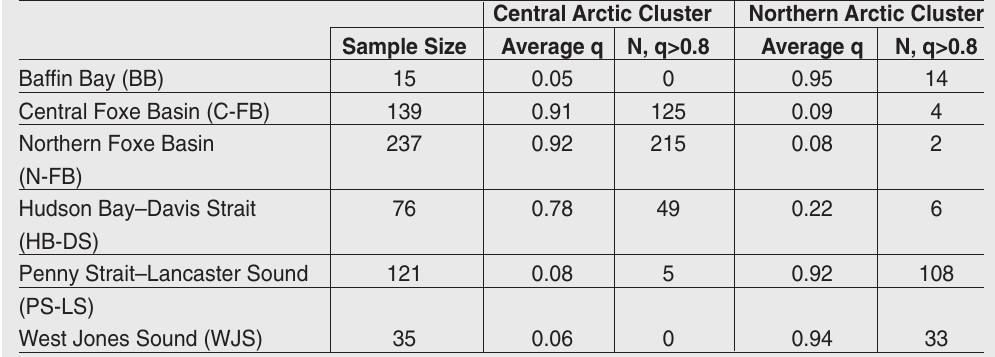
Table 5 . Genetic assignment matrix. Average assignment and number of individuals strongly assigned (q>0.80) from each stock to the central Arctic and northern-Arctic genetic clusters inferred from STRUC-